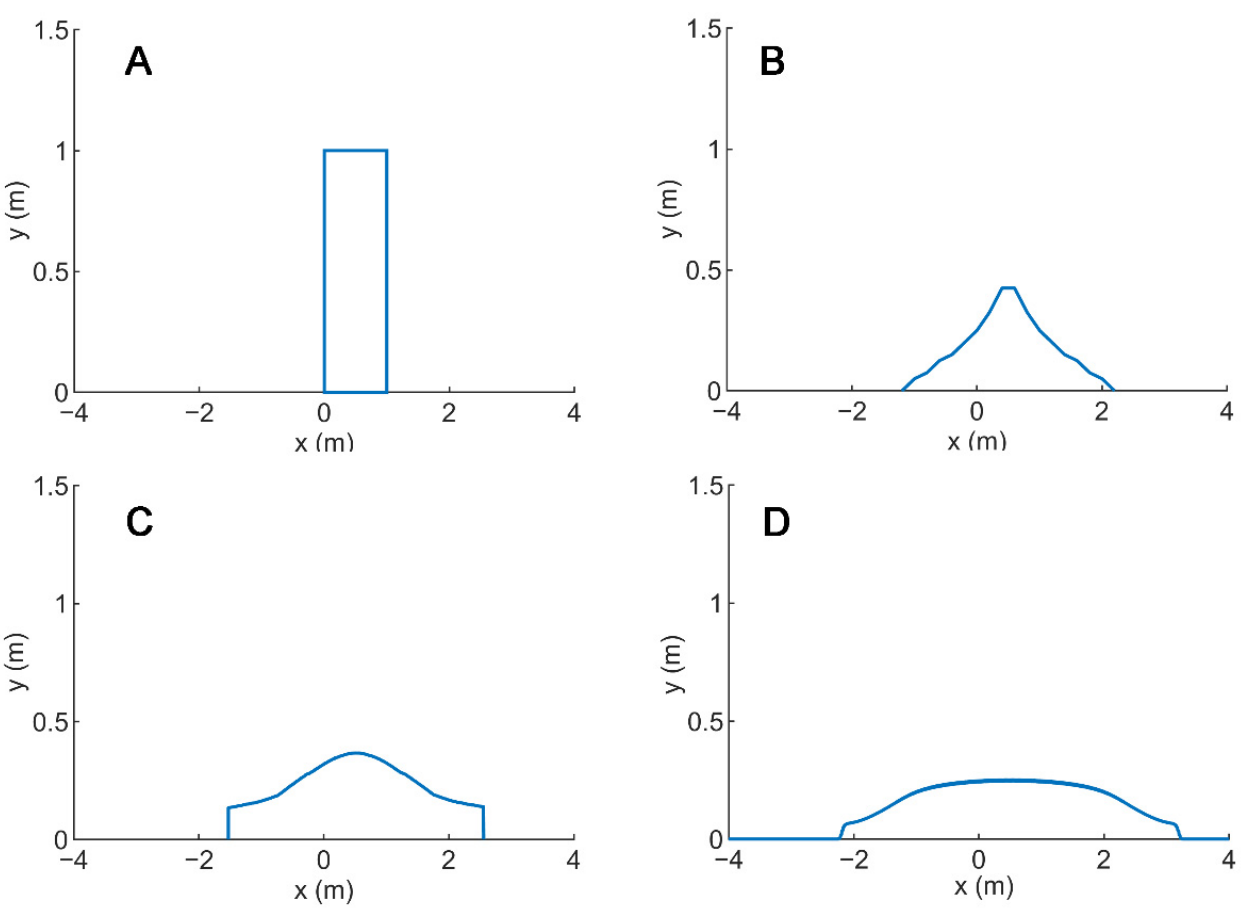
Figure 3. Bilateral dam break simulation with different models: ( A ) the initial state of the simulation, ( B ) obtained by OpenFOAM at 0.5 s, ( C ) obtained by PySPH at 0.5 s, and ( D ) obtained by the depth-averaged model at 0.5 s.